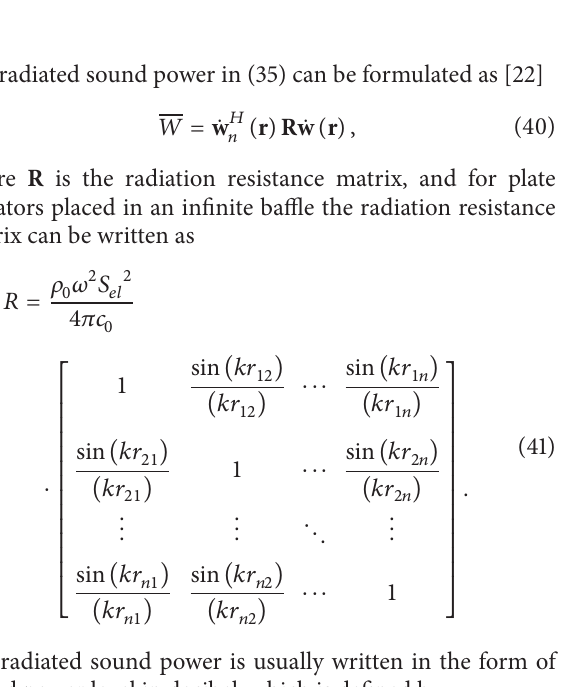
was calculated using SYSNOISE in Jeyaraj et al. [5]. The